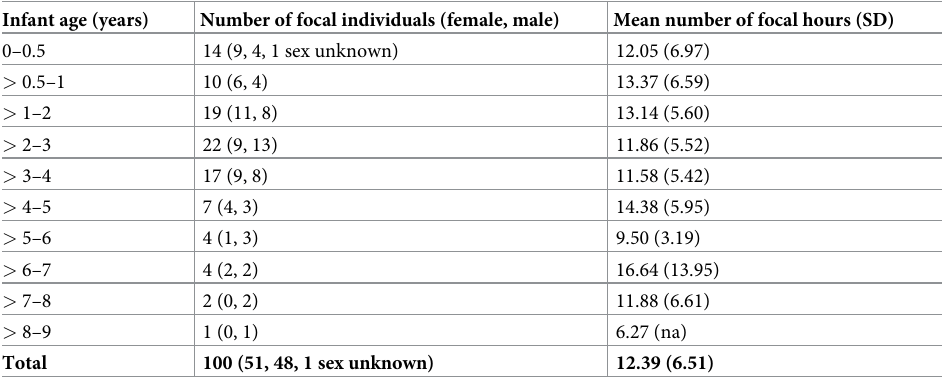
Table 1. Study subjects and focal sampling